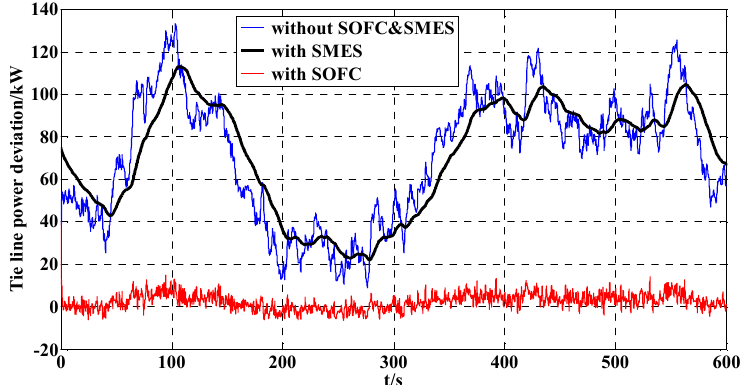
Figure 9. Tie-line power deviation for case A and case